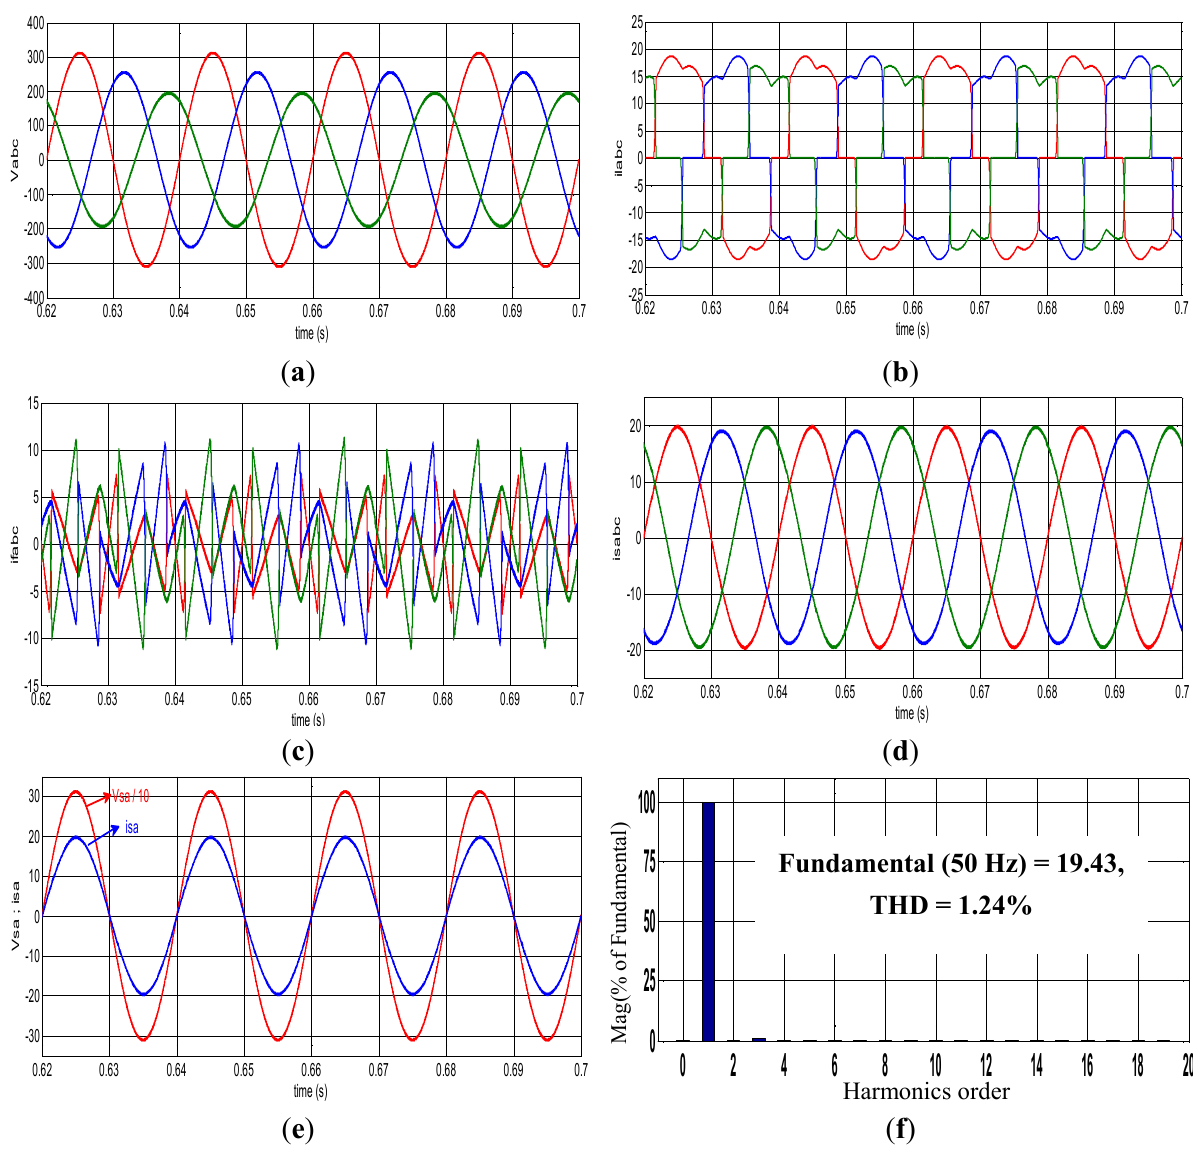
Figure 13. Simulation results for unbalanced sinusoidal grid voltage: ( a ) three-phase line voltages; ( b ) three-phase load currents; ( c ) three-phase filter currents; ( d ) three-phase line currents; ( e ) line voltage and current, phase-a; ( f ) frequency spectrum of line current,